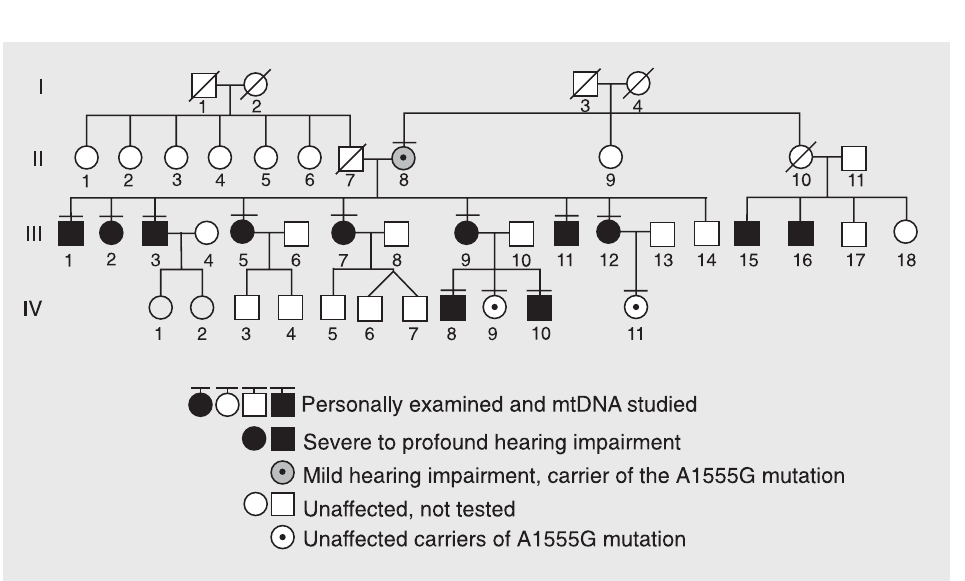
Figure 1. Pedigree of Family 1 with mtDNA A1555G